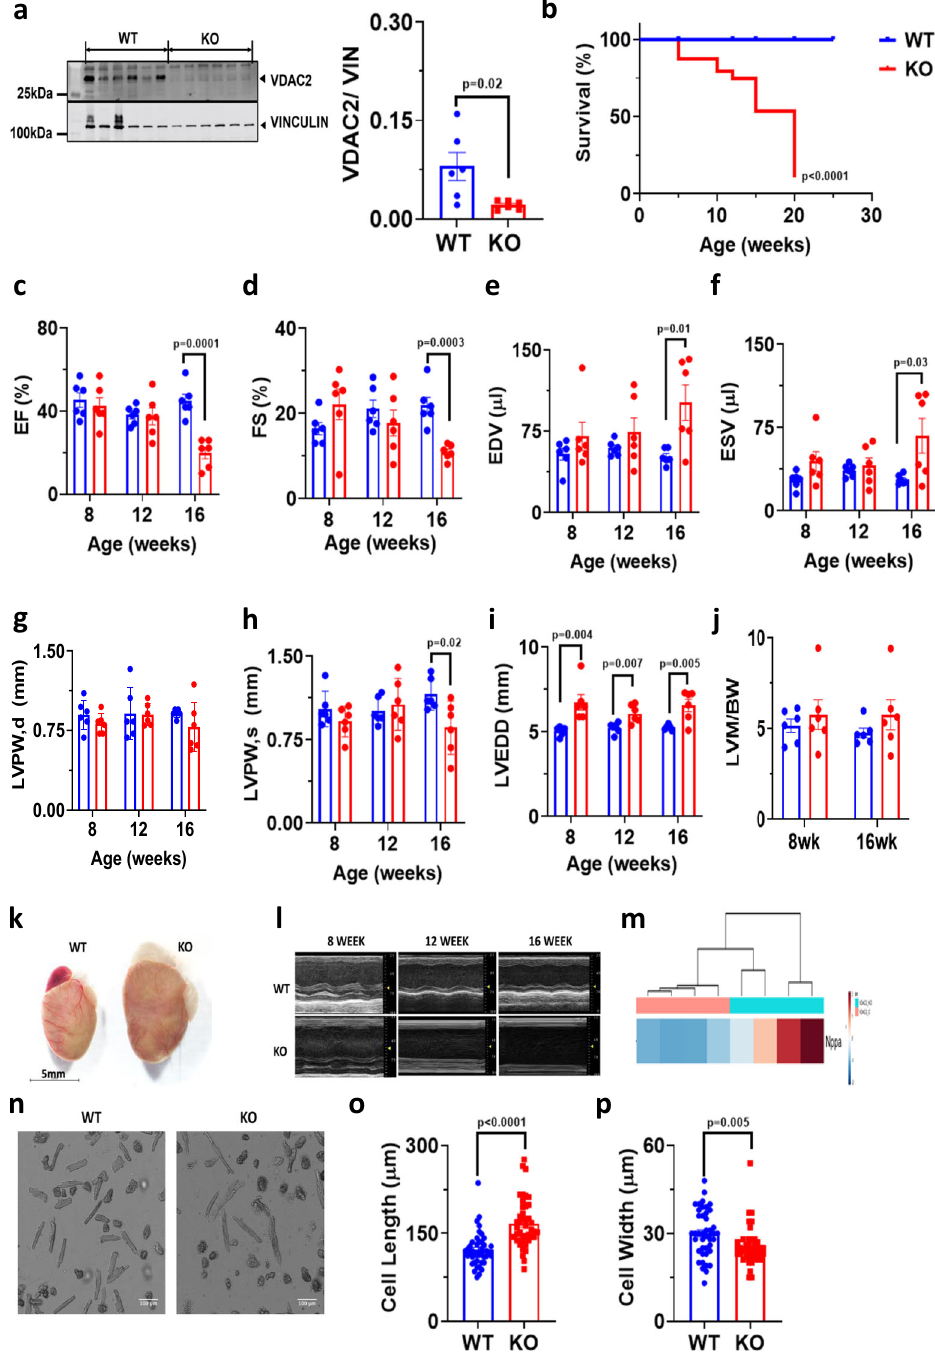
Fig. 1 Cardiac-speci fi c deletion of VDAC2 causes dilated cardiomyopathy and leads to increased mortality. a Western blot image of VDAC2 and lane- loading control VINCULIN and quanti fi cation in WT (Wild-type) and KO (Knock-out) using Image Studio Lite (version5.2.5) ( p = 0.02) ( n = 6); b Kaplan – Meier survival curve ( n = 10) ( p < 0.0001); c – j Echocardiography analysis of left ventricular ejection fraction (EF) ( p = 0.000143), fractional shortening (FS) (0.000376), left ventricular end-diastolic and end-systolic volumes (EDV and ESV) ( p = 0.0132 and p = 0.0311), left-ventricular posterior wall thickness at diastole and systole (LVPW,d and LVPW,s) ( p = ns and p = 0.0244), left ventricular end-diastolic diameter (LVEDD) (8-week p = 0.004824; 12-week p = 0.007670 and 16-week p = 0.005986) ( n = 6) and j left ventricular mass to body weight ratio (LVM/BW), respectively ( n = 6); k Representative heart image of 16-week-old mice (scale bar, 5 mm); l Representative m-mode image from echocardiography ( n = 1); m Differential expression of NPPA gene ( n = 4); n Representative ventricular cardiomyocyte image using confocal microscopy (scale bar, 100 μ m ); o , p Cardiomyocyte cell length ( p < 0.0001) and width ( p = 0.0058) measured using Zen5 imaging software, respectively ( n = 42, N = 3). p -value: unpaired two-tailed t -test performed in panels a , o , and p , Mantel – Cox test performed in panel b and two-stage set-up multiple t -test (Benjamini, Krieger, and Yekutieli) performed for longitudinal echocardiographic data. Data are represented as differences between mean ±